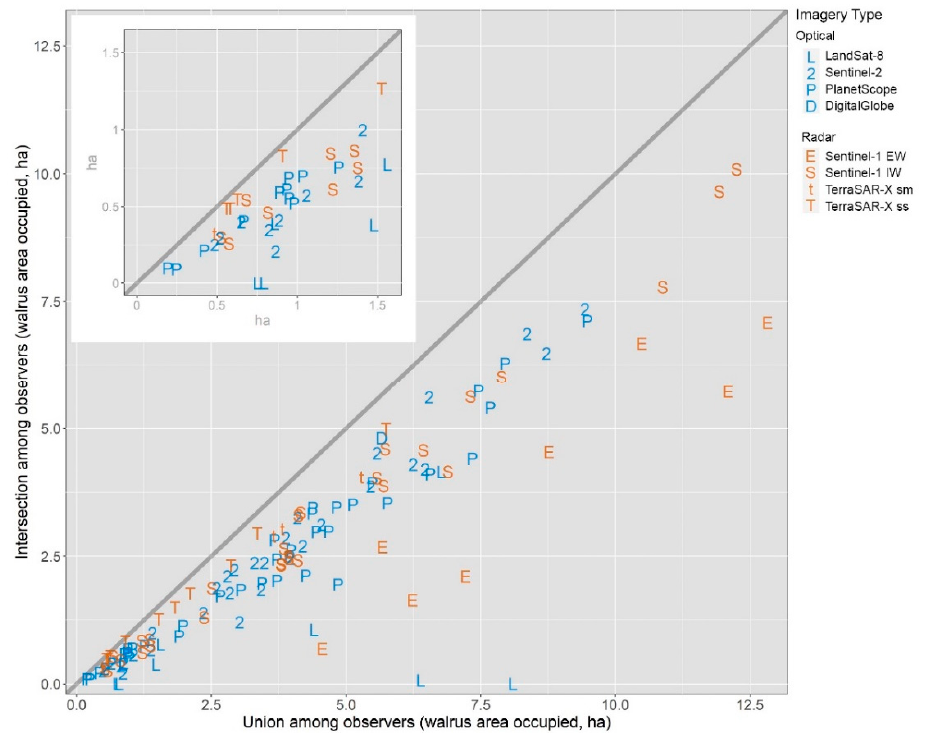
Figure 4. Variation among observers in determining both the location and size of walruses from satellite images. The area of 3-way intersection among the observers’ delineations of walrus aggregations in each satellite image (y axis) are plotted on the area of the geographic union of the observers’ delineations. A perfect 3-way spatial agreement would attain a 1:1 ratio. Symbols: as in Figure 2. Linear regression slopes for each imagery type are displayed in Table 1. One Sentinel-1 EW outlier was excluded from this graph: x = 20.11, y = 10.75).